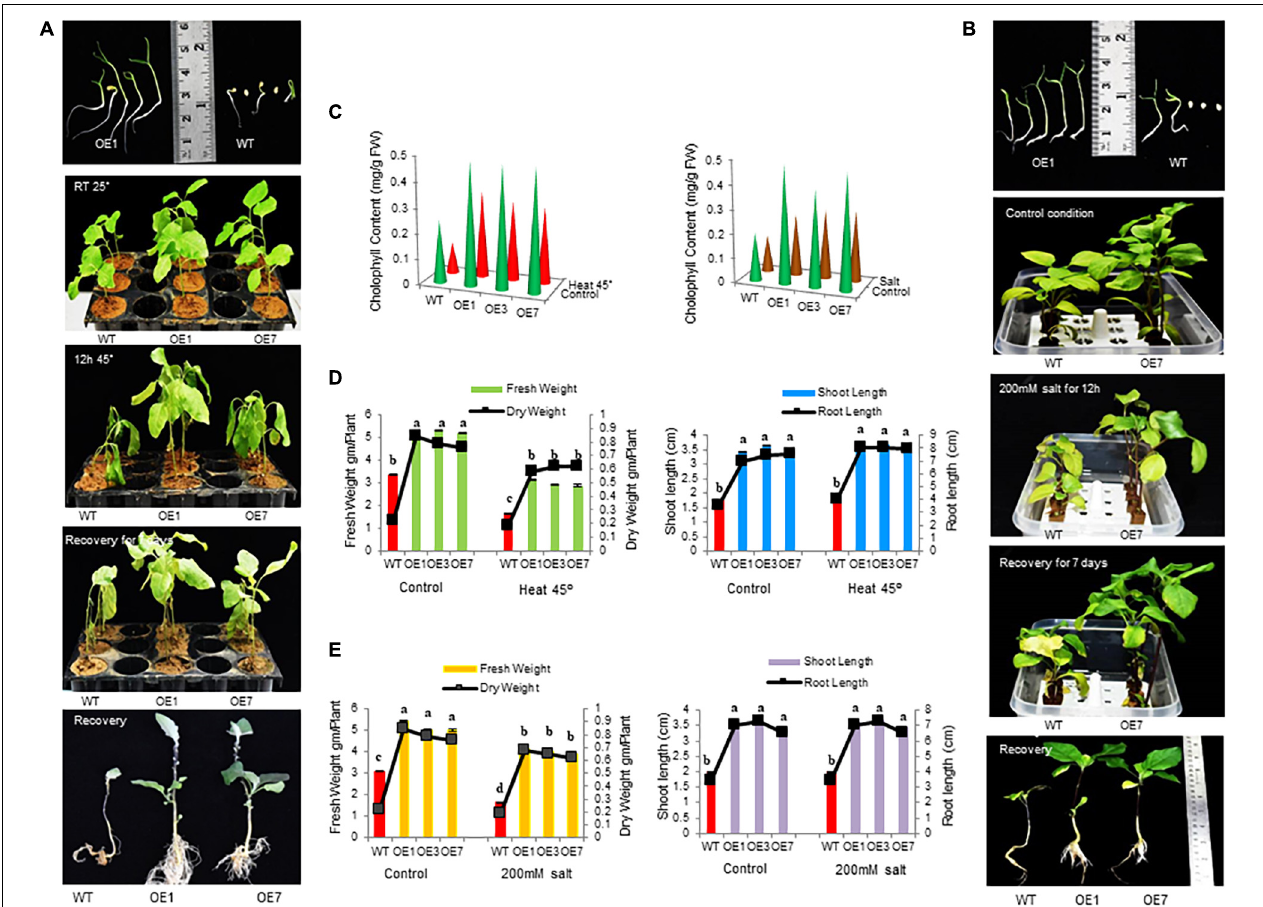
FIGURE 3 | Growth parameters of transgenic eggplant lines overexpressing SmsHSP24.1 protein under heat and salt-stressed conditions. (A) Growth parameters of transgenic (OE) as well as WT eggplant lines at 45 ◦ C. (B) Growth parameters under 200 mM NaCl salt stress condition of the transgenic (OE) and WT eggplant lines. (C–E) Total fresh weight, dry weight, root length, shoot length, and chlorophyll contents were significantly higher in all transgenic seedlings compared with the WT line. Data are M ± SD ( n = 3). The letters a, b, c, and others indicate significant differences between different lines ( P <